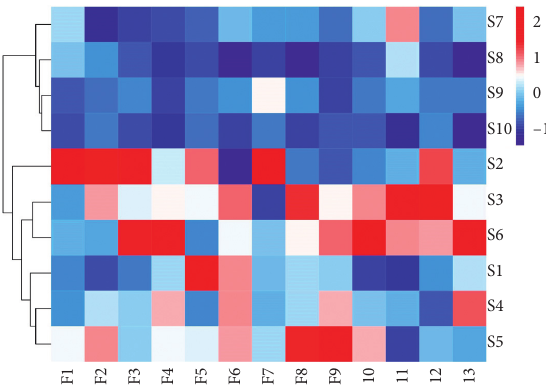
Figure 3: Heatmap of peak areas from 10 batches of samples by Z - score.